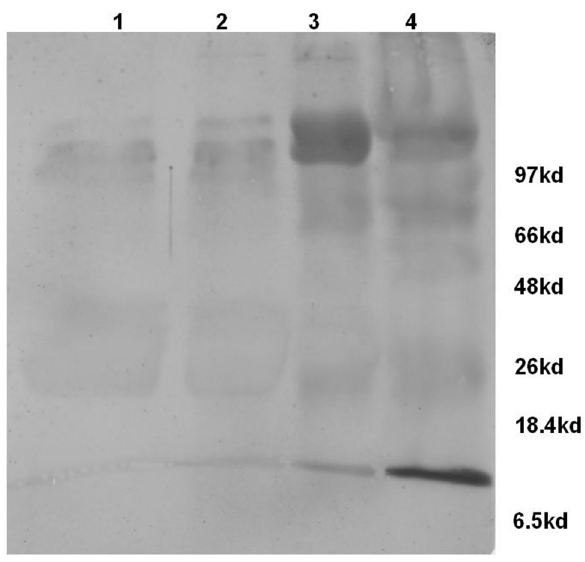
Figure 3. Western blot analysis of bovine milk whey proteins (Lane 1—Normal; Lane 2—Mastitis (M+); Lane 3—Mastitis (M++); Lane 4—Mastitis (M+++)) for the presence of complement component—C3 and its activated products. Mastitis milk samples show the presence of α -chain of C3b (~105 kda), β -chain of C3 (~75 Kda) and C3a (~9 Kda).